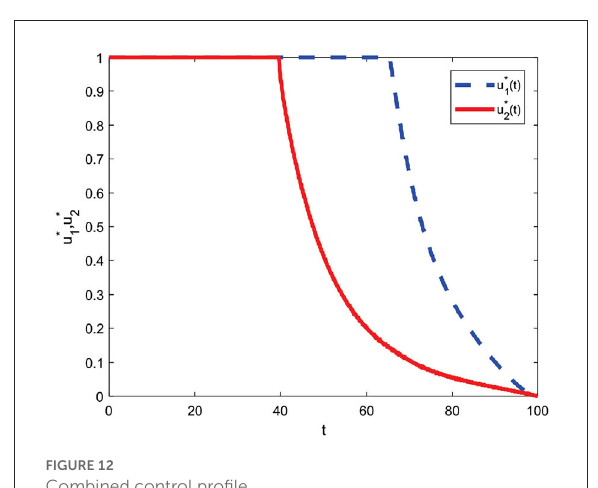
FIGURE12 Combined control